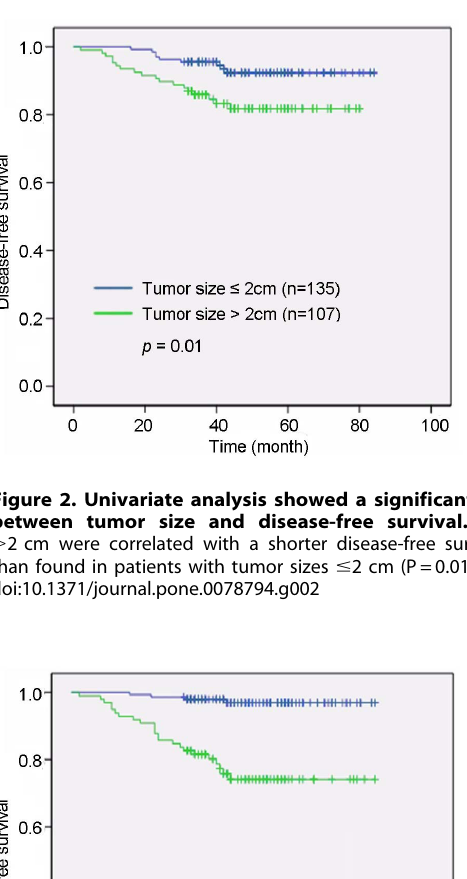
(Table 2). Multivariate analysis using the stepwise backward elimination method revealed that lymph node involvement (HR 10.892, 95% CI 3.39–35.00, P , 0.001) and MDM2 expression